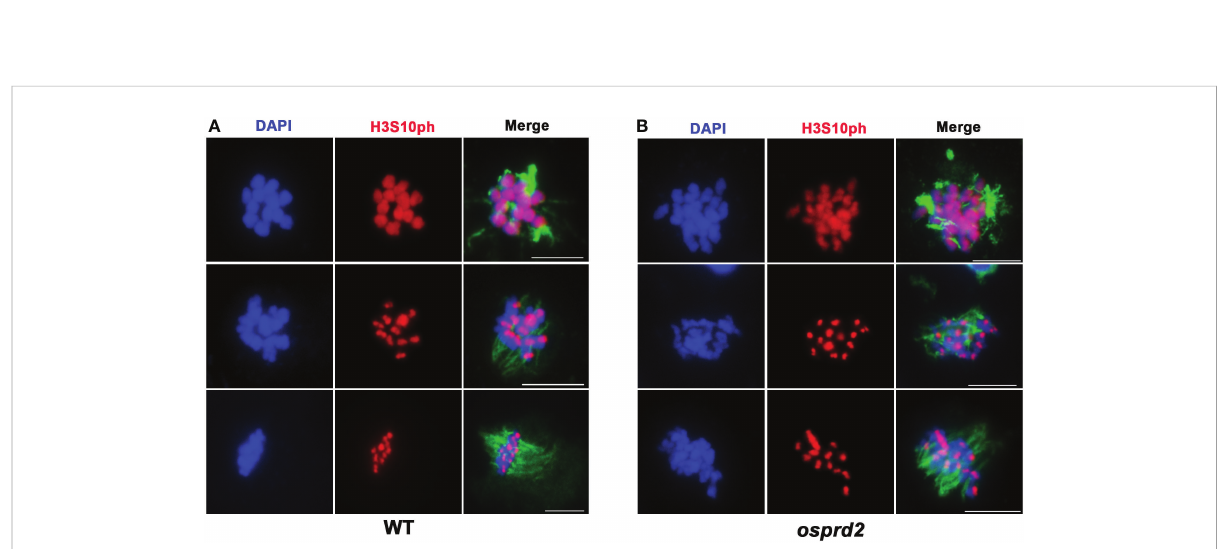
FIGURE 9 H3S10 signal in wild type and osprd2 mutant. (A) is H3S10 localization in wild type; (B) is H3S10 localization in osprd2 mutant. blue are chromosomes, red are H3S10ph signals and green are tubulin signals. Bar=2 m